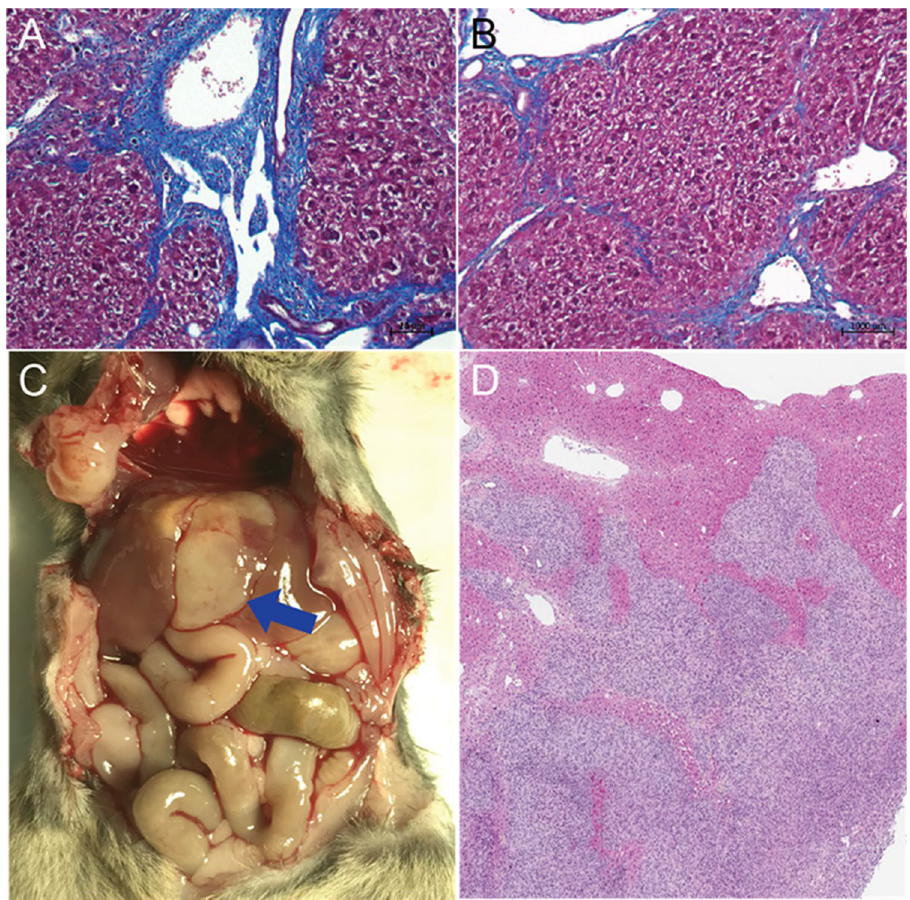
Figure 1. Characterization of syngeneic murine HCC tumor model with cirrhosis. ( A , B ) Trichrome staining of liver tissue following 12 weeks of oral gavage of carbon tetrachloride demonstrates periportal and bridging fibrosis, recapitulating the histologic findings in human cirrhosis. ( C , D ) Orthotopic tumor implantation (blue arrow) exhibits a high rate of engraftment as well as a diffuse, infiltrative phenotype, a pattern commonly seen in aggressive hepatocellular carcinoma in